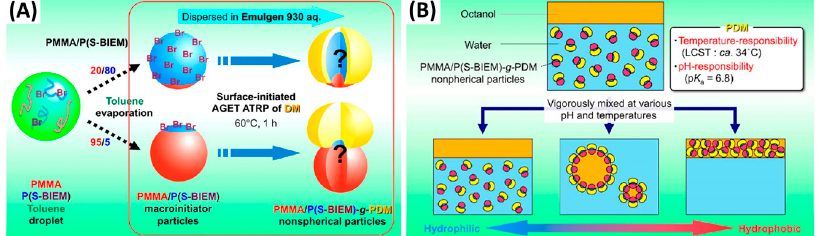
Figure 20. ( A ) Preparation of mushroom-like Janus polymer particles by site-selective surface-initiated activator generated by electron transfer (AGET) ATRP in aqueous dispersed systems; ( B ) The scheme of whole behaviors of Pickering emulsion formed by stimuli-responsive “mushroom-like” Janus polymer particles. Adapted with permission from [143]. Copyright 2014, American Chemical Society.